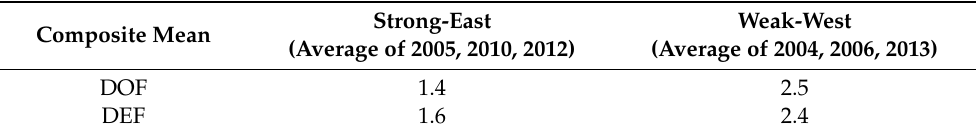
Table 1. Composite means in DOF and DEF for the Strong-East and Weak-West